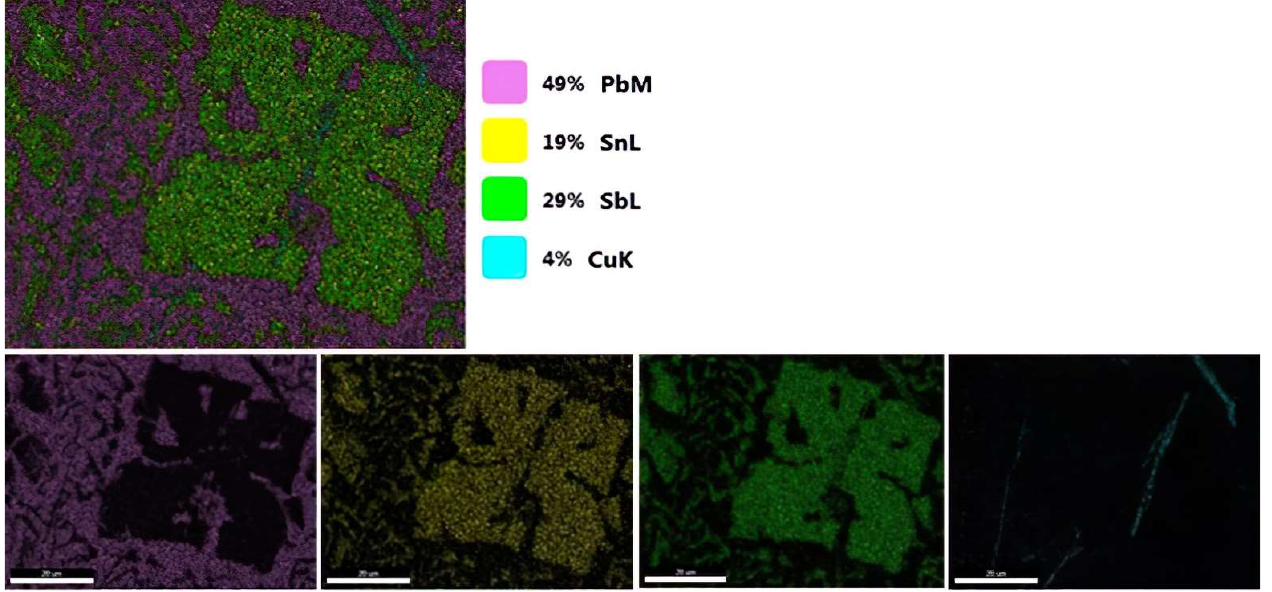
Figure 2. Mapping analyses of the compounds formed during Ca microalloying.